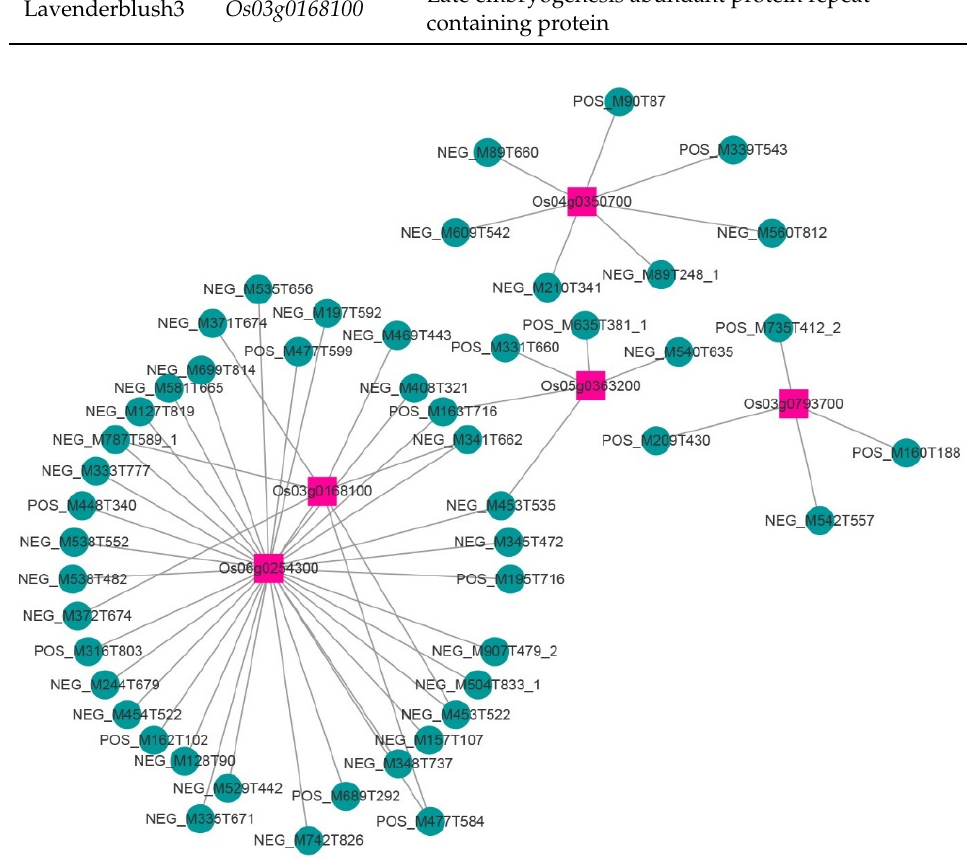
Figure 5. Core gene and metabolite connectivity network diagram.